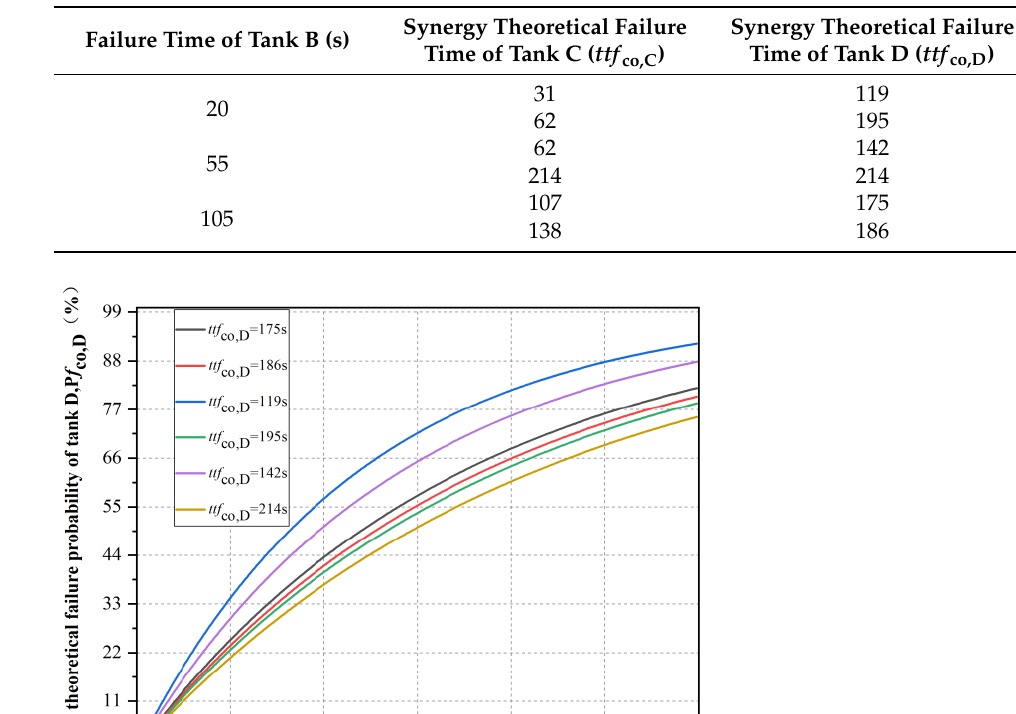
Table 4. Failure probability of storage